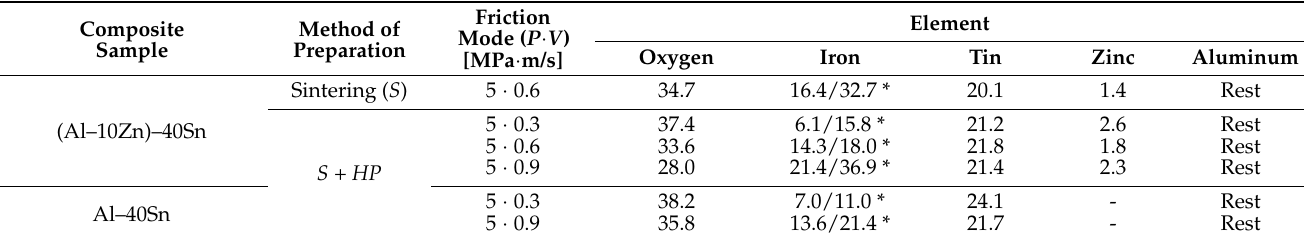
Table 4. Elemental composition (wt.%) of the friction surface of the CM samples. Sintering mode: 600 ◦ C; 1